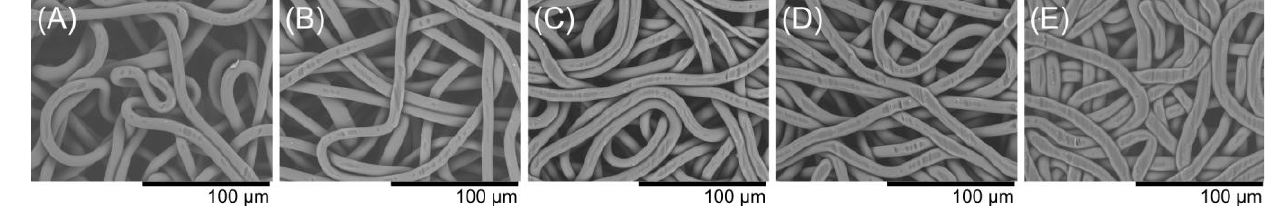
Figure 4. Scanning electron microscope images. ( A ) 8-ply laminated product, ( B ) 10-ply laminated product, ( C ) 12-ply laminated product, ( D ) 14-ply laminated product, and ( E ) 16-ply laminated product.